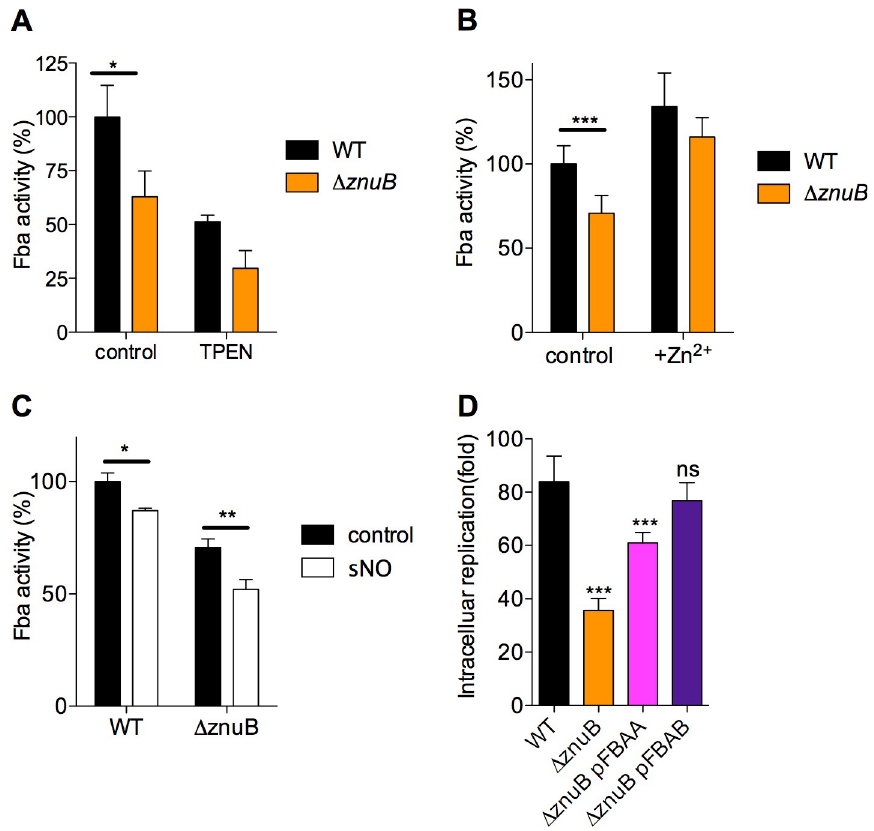
Fig 4. Fructose bisphosphatate aldolase content. (A) Fructose-1,6-bisphosphate aldolase (Fba) activity in Salmonella lysates. Where indicated, the lysates were treated with 100 μ M of the zinc chelator TPEN. The Fba activity was normalized to WT samples. N = 12, mean ± S.E.M. (B) Effect of the supplementation of EG minimal media with 5 μ M ZnCl 2 on the Fba activity of log phase Salmonella . N = 8, mean ± S.D. (C) Fba activity in Salmonella treated for 5 min with 750 μ M spermine NONOate. N = 8, mean ± S.D. � , �� , ��� p < 0.05, < 0.01, < 0.001, respectively, as determined by two-way ANOVA. (D) Growth of Δ znuB Salmonella after 16–20 h of culture in J774 cells. Where indicated, Δ znuB Salmonella were complemented with fbaA or fbaB genes heterologously expressed from the pBAD promoter. N = 8–16; mean ± S.D. ��� , p < 0.001 as determined by one-way